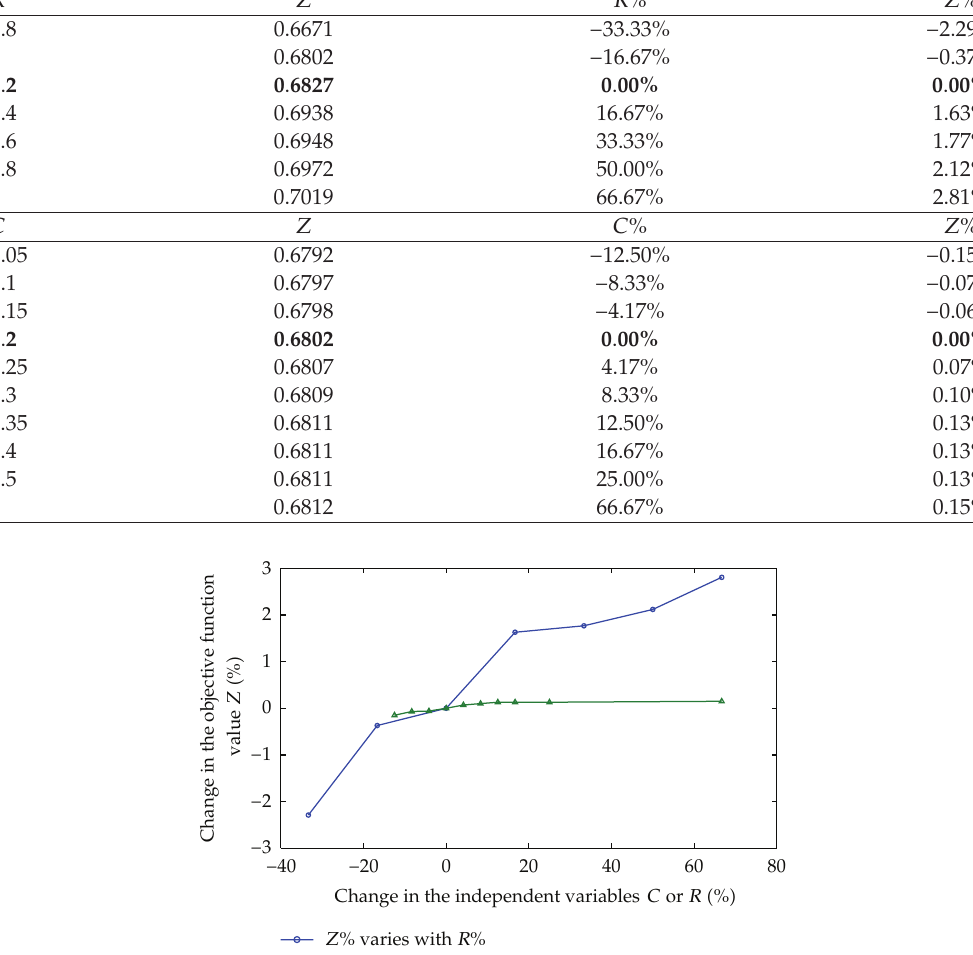
Table 7: Influence on the comprehensive performance of LSSC caused by time delay and cost increase.